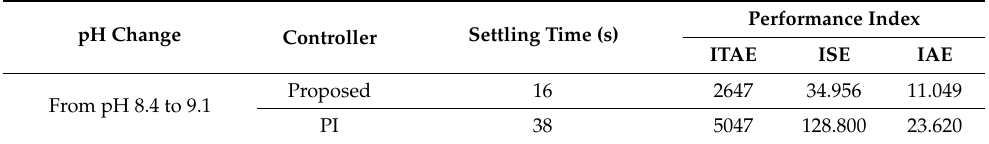
Table 5. The performance comparison of the controllers for pH control.